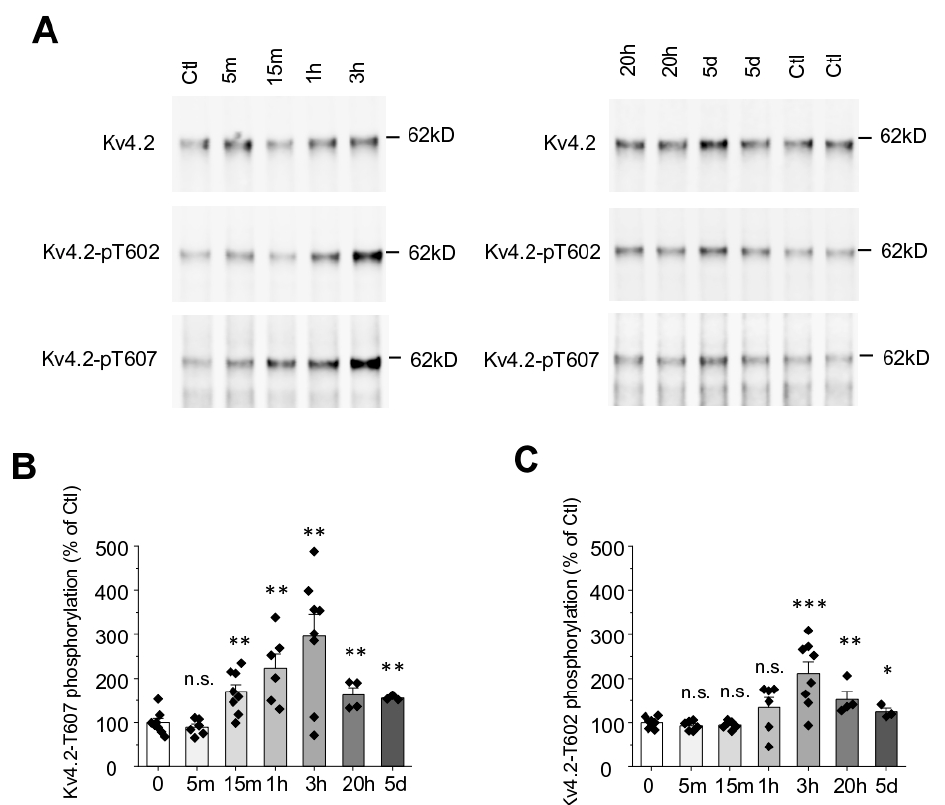
Figure 2. Seizure induced by kainic acid triggers Kv4.2 T607 phosphorylation in a time-dependent manner in mouse hippocampus. ( A ) Time course of Kv4.2 phosphorylation at Thr602 and Thr607 by kainic acid administration (25 mg/kg, i.p.) in mouse hippocampus. ( B ) Statistical analysis of kainic acid-induced phosphorylation of Kv4.2 at Thr607 in mouse hippocampus, n = 3 – 8 in each group, t - test, ** p < 0.01. ( C ) Statistical analysis of kainic acid-induced phosphorylation of Kv4.2 at Thr602 in mouse hippocampus, n = 3 – 8 in each group, t -test, * p < 0.05, ** p < 0.01, *** p < 0.001.